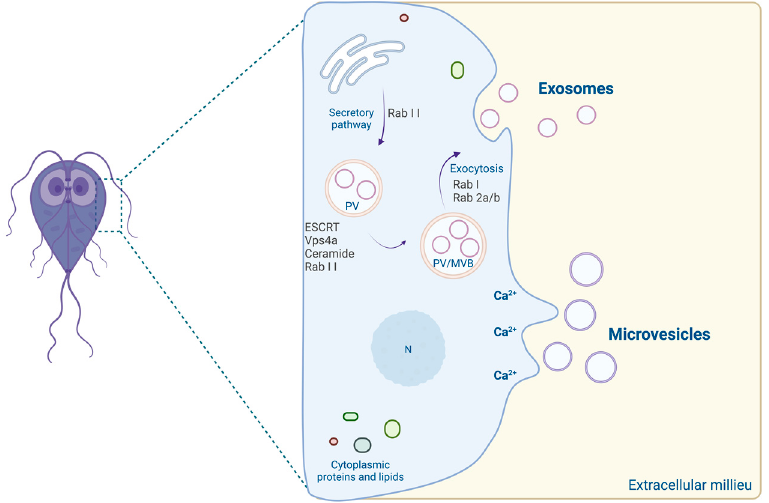
Figure 1. Proposal biogenesis of Giardia EVs . (PV: peripheral vacuoles; ESCRT: endosomal sorting complexes required for transport; MVB: multivesicular bodies; N: nucleus) (created with BioRender.com).